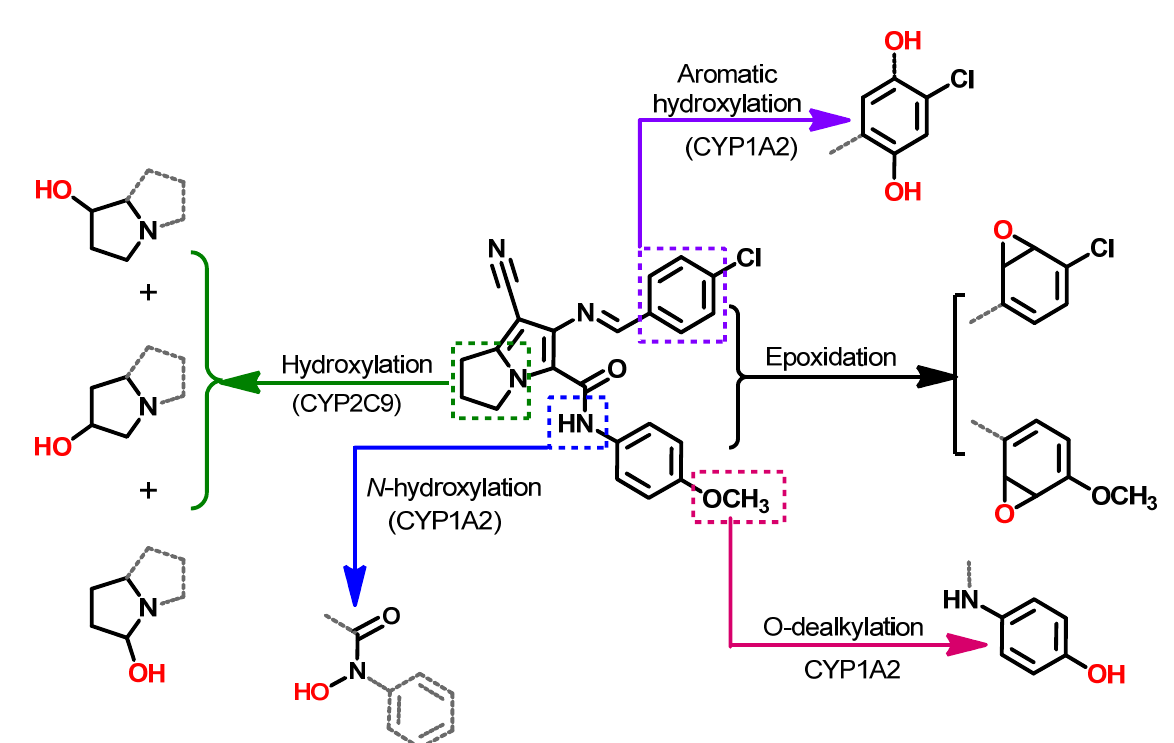
Figure 23. Expected phase I metabolic pathways and metabolites of compound 16g in